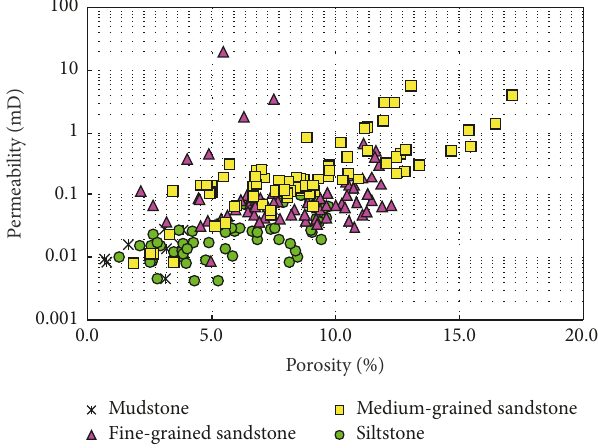
Figure 4: Core porosity versus core permeability cross-plots for various lithologies within Chang 8 oil layers in Ordos